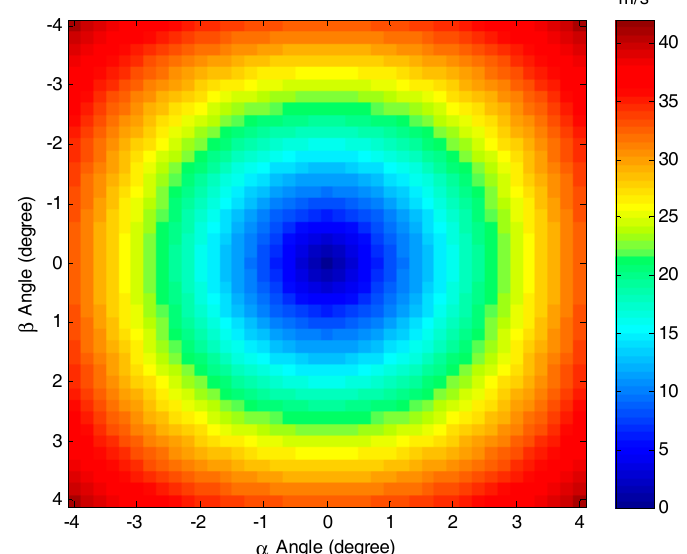
Figure 2. The maximum radial velocity at different pointing angles when observing Saffir–Simpson Hurricane Wind Scale (SSHS)-5 by GSDWR when the pointing angles α and β are +4° or − 4°, with a maximum radial velocity of 40.7 m/s.